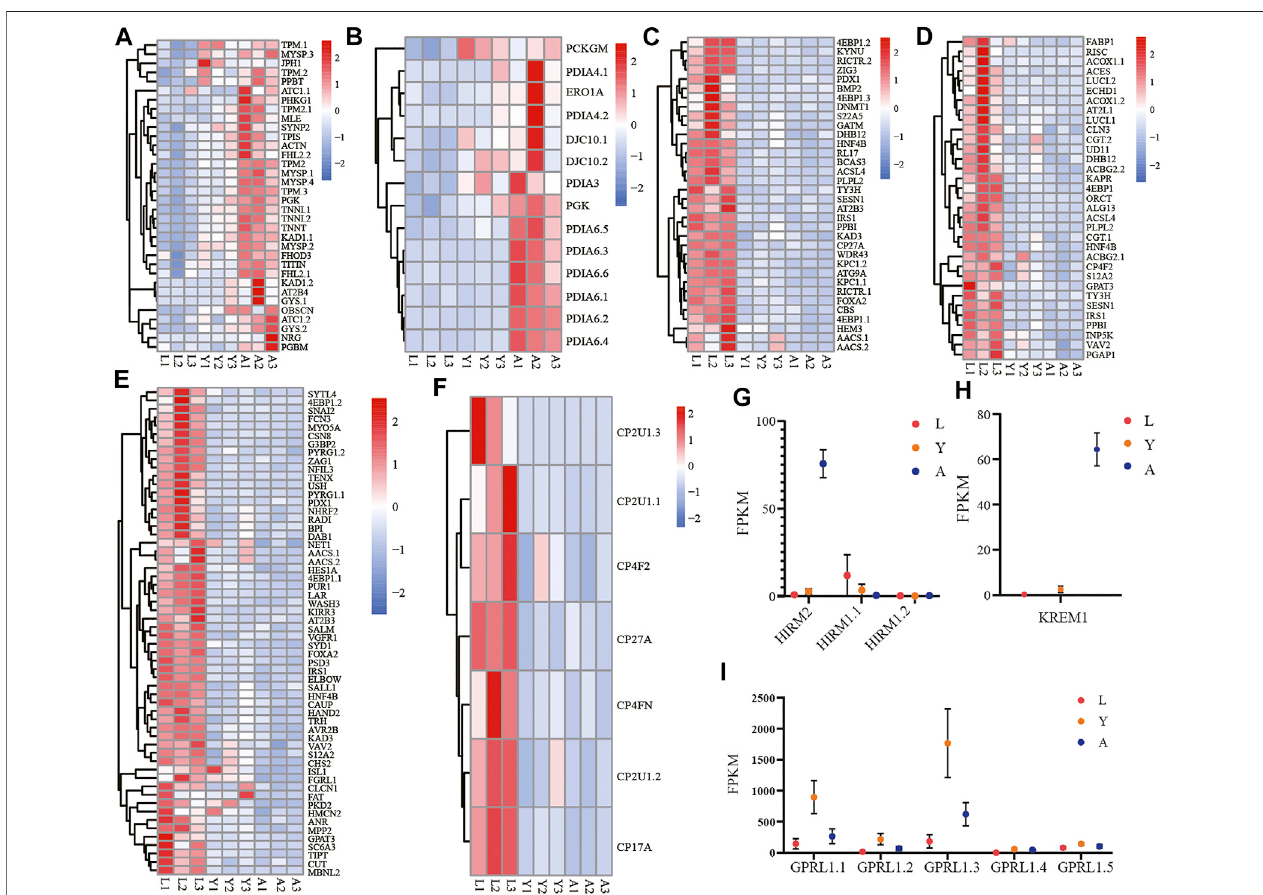
FIGURE6| Expressionofimportantgenefamiliesrelatedtogrowthanddevelopment.Thegenefamilyexpressionof (A) musclecellularcomponent – relatedgenes; (B) disul fi de oxidoreductase activity; (C) response to stimulation and nutrition-related genes; (D) cellular lipid metabolism – related genes; (E) gland development, respiratorysystemdevelopment,andcompoundeyedevelopment-relatedgenes; (F) cytochromeP450 – relatedgenes; (G) HIRM2 (hirudin-HM)and HIRM1 (hirudin); (H) KREM1 ; (I) GPRL1 in three different growth periods of H. manillensis.